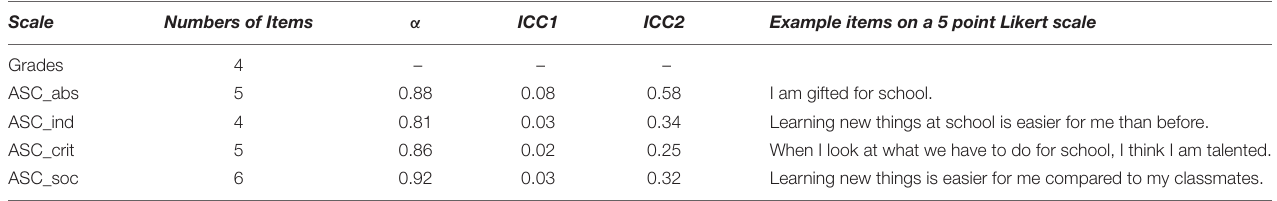
TABLE 2 | Number of items, reliability (Cronbach’s α ), ICC1 and ICC2 for dependent variables and example item.